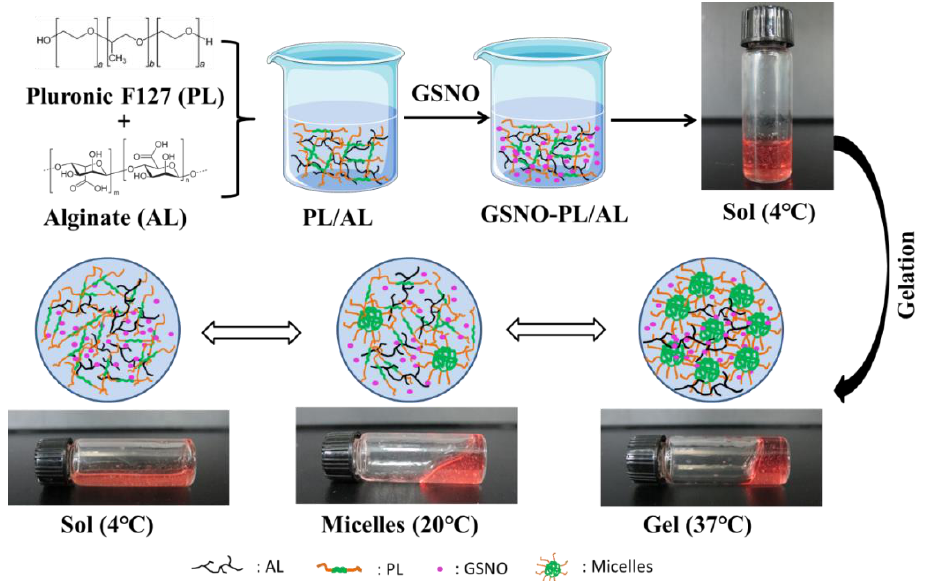
Figure 1. Schematic diagram of GSNO-PL / AL hydrogel synthesis and sol − gel transition. AL: alginate, GSNO: S-nitrosoglutathione, PL: pluronic F127.